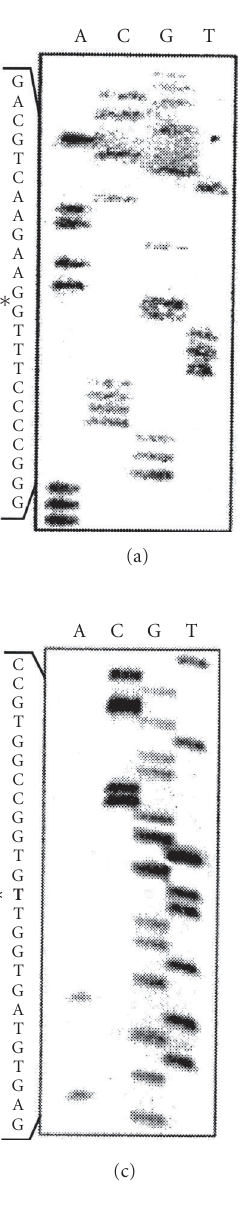
Figure 3: Detection of mutations in Tunisian LAD patients CD18 and cDNA. The DNA sequences shown were performed on cloned PCR products obtained by RT/PCR of the patients PBMC total RNA. (a) Nucleotide sequence showing the deletion of a single G (1920delG) in the glycine codon at position 640 causing a frame shift introducing a stop codon 16 residues downstream. The mutated CD18 protein ends as following: GPFG FS RTAARRVRPCSCRTTP • (b) Detection of the G (1497delG) in the aspartic acid at position 500, causing a frame shift and a stop codon 28 residues downstream. The CD18 protein is truncated as following: SCRK FS TTTPSS AQGWRTVSAG SACATPATSPAS • (c) The C to T transition causing the substitution Arg 593 by Cyst detected in patient K is indicated by an asterisk. (d) Nucleotide sequence showing the missense mutation that affects residue 284 of the Cd18 in patients S and S changing a C into a G. FS = frame